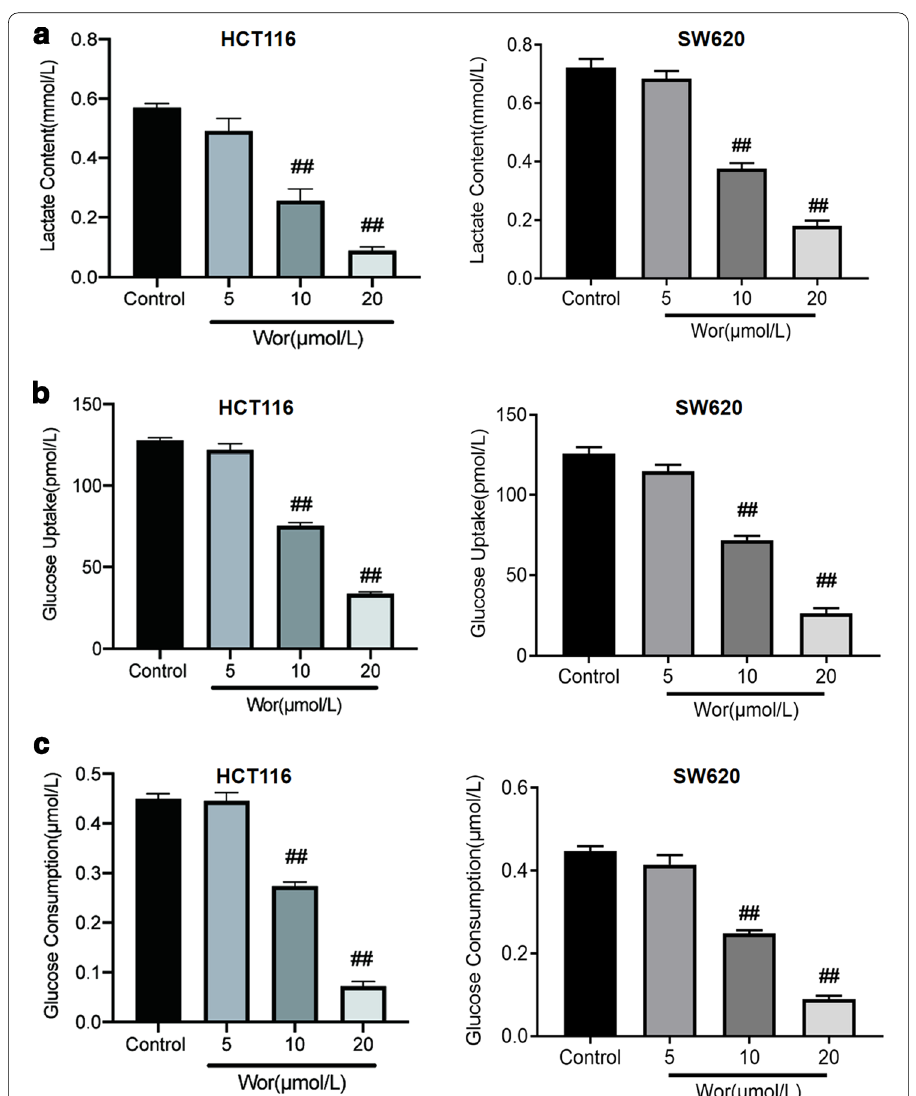
Fig. 2 Glucose consumption, glucose uptake and lactate release for colorectal cancer cells after worenine treatment. a The lactate level in the supernatant was determined using a lactic acid production detection kit. b Glucose uptake was evaluated using a glucose uptake colorimetric assay kit. c Glucose consumption was evaluated using a glucose assay kit. The data are means SEM. # p < 0.05, ## p < 0.01 vs. control ±